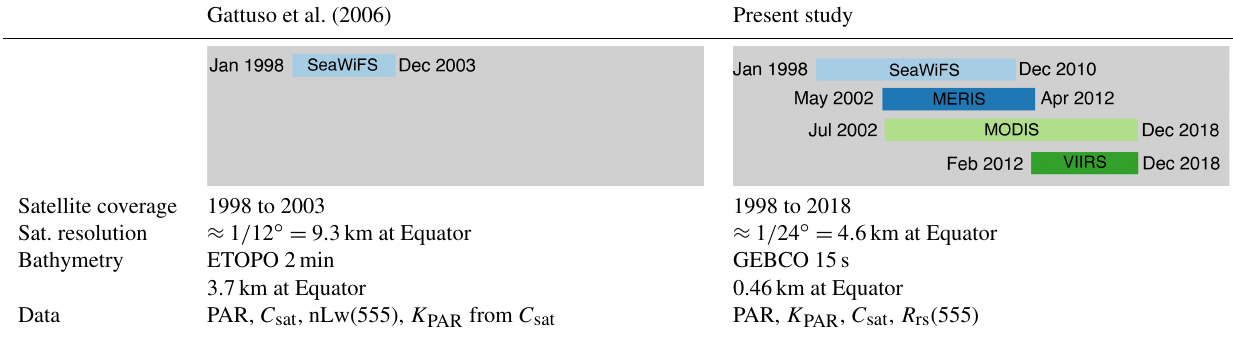
Table 1. Main characteristics of the products used by Gattuso et al. (2006) and of those in the present study. Gattuso et al. (2006) Present study